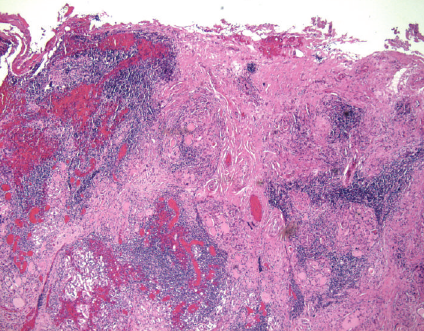
Figure 2: Case 2. Rare atrophic follicles with intraluminal colloid. Marked inflammation with extensive lymphocytic infiltration with some germinal centres and associated peripheral fibrous septa.